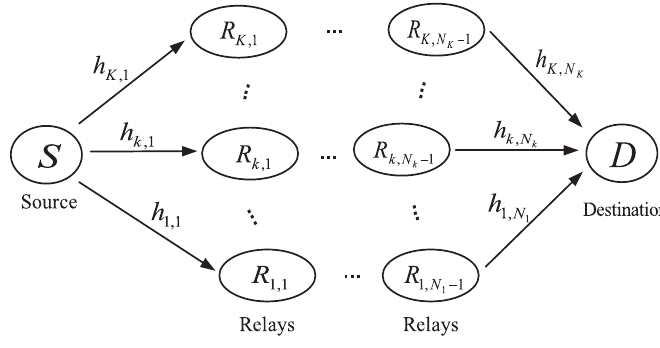
Figure 1. A multi-hop WSN with parallel relays from a source to a